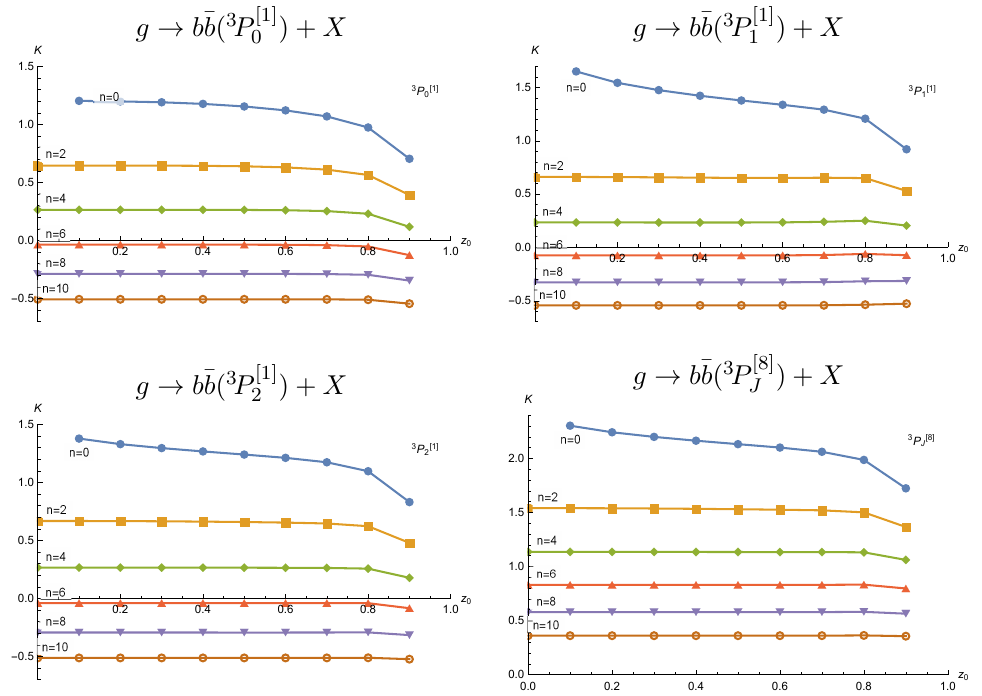
Figure 8 . The K-factors calculated by the integration results with eq. (4.3) for different z 0 and n